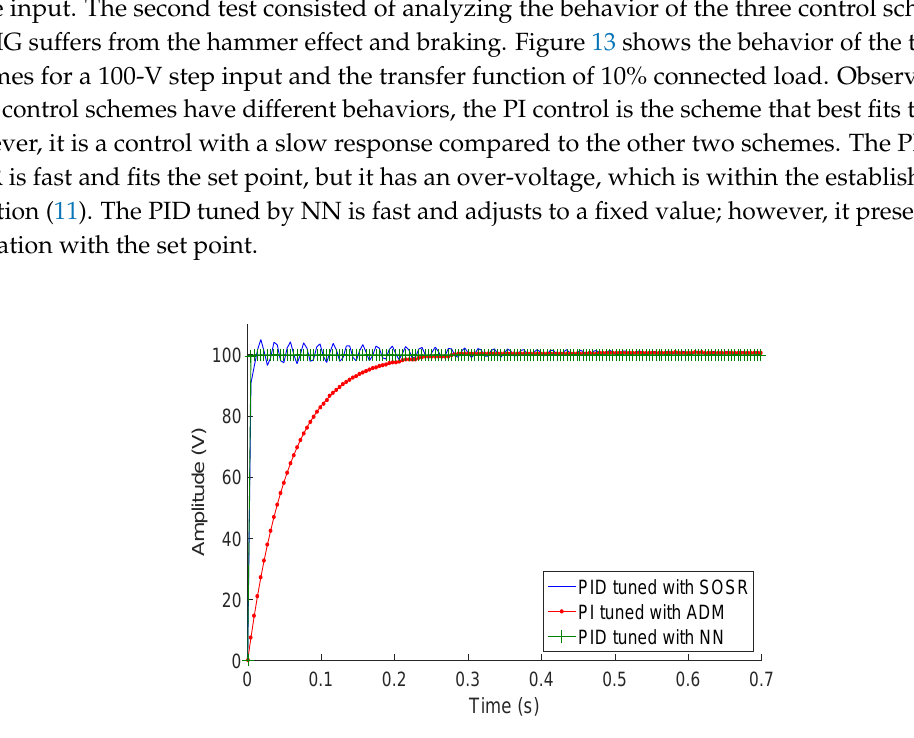
Figure 13. Step response for an input of 100